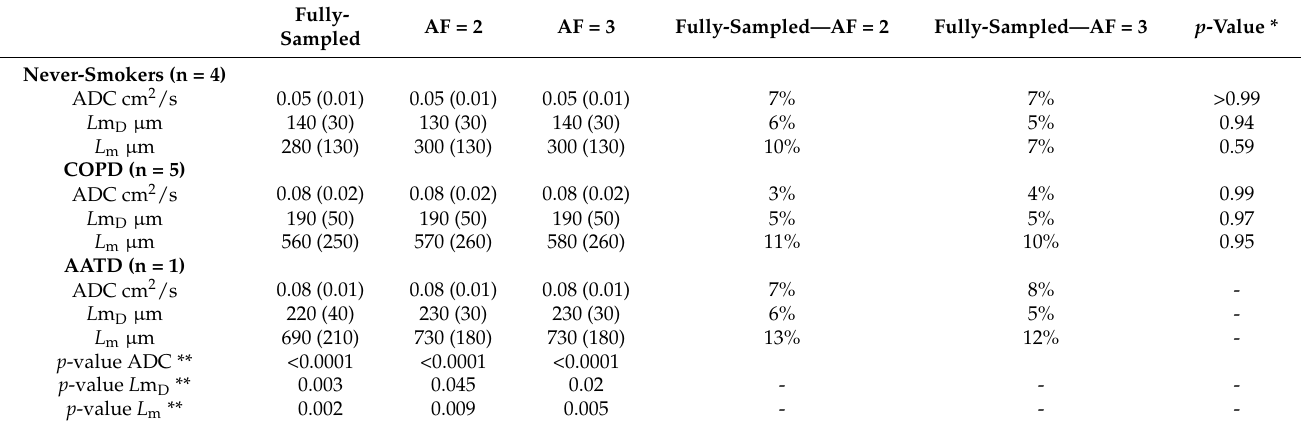
Table 2. Imaging measurements and morphometry